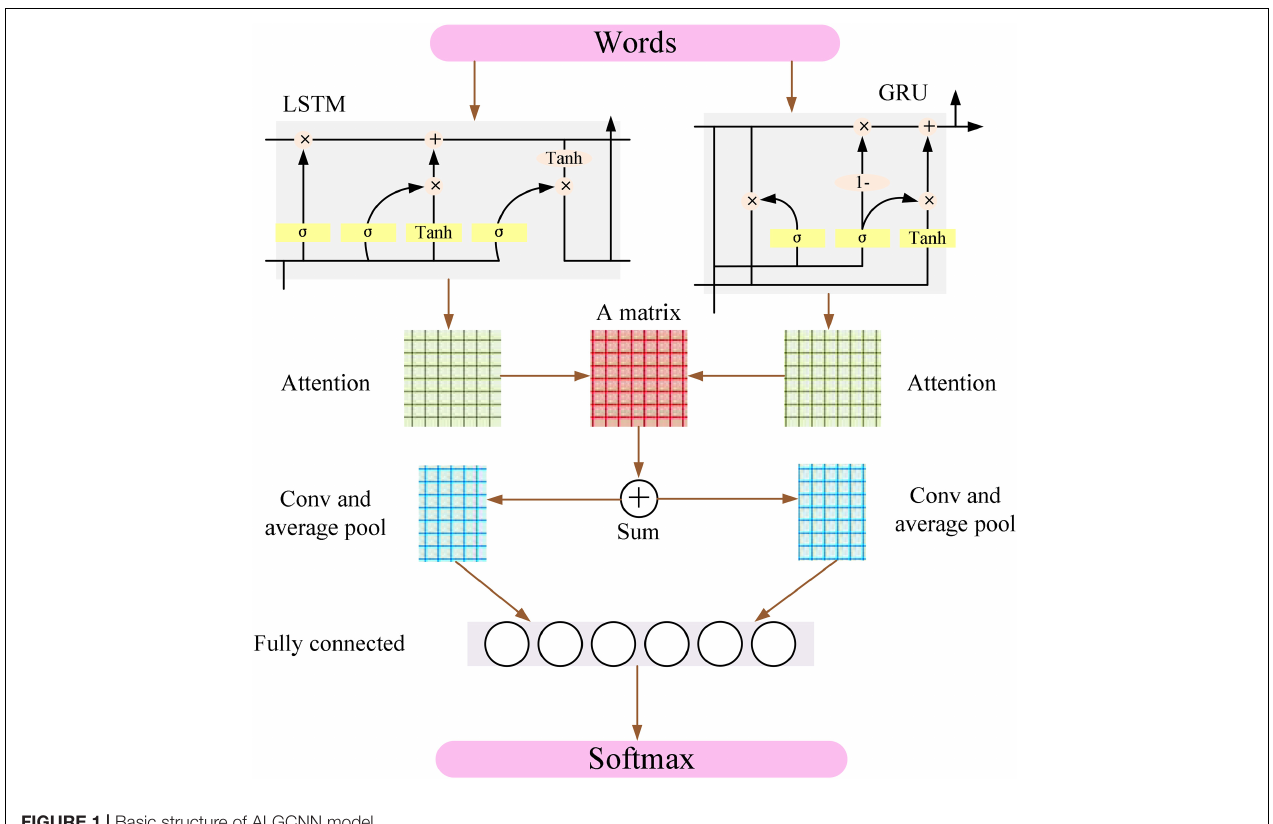
FIGURE 1 | Basic structure of ALGCNN model.